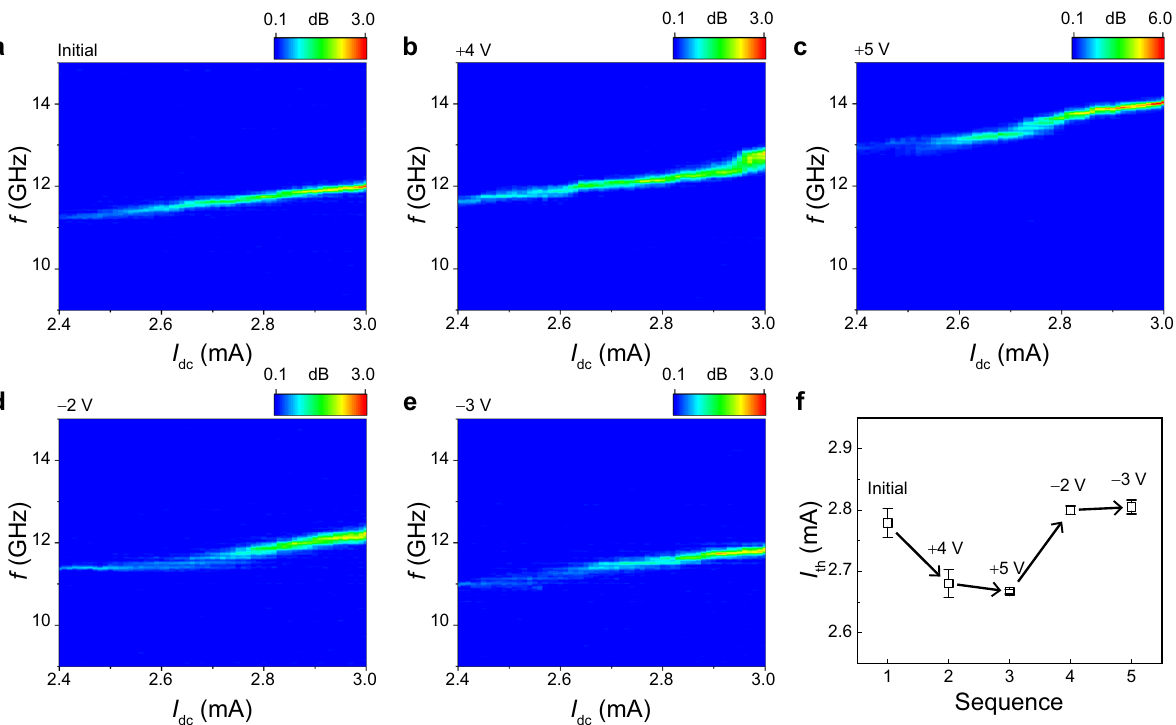
Fig. 4 Current-dependent voltage-driven frequency tuning of SHNO. a – e PSDs as a function of current for sequentially applied gate voltages, V g = 0 V (initial state) ( a ), V g = + 4 V ( b ), V g = + 5 V ( c ), V g = − 2 V ( d ), and V g = − 3 V ( e ). B = 0.56 T. f , Threshold current ( I th ) according to the sequentially applied gate voltages, extracted from Fig. 4a – e. The error bars are due to the uncertainty in the linear fi t of the data in Supplementary Fig. 13a – e.